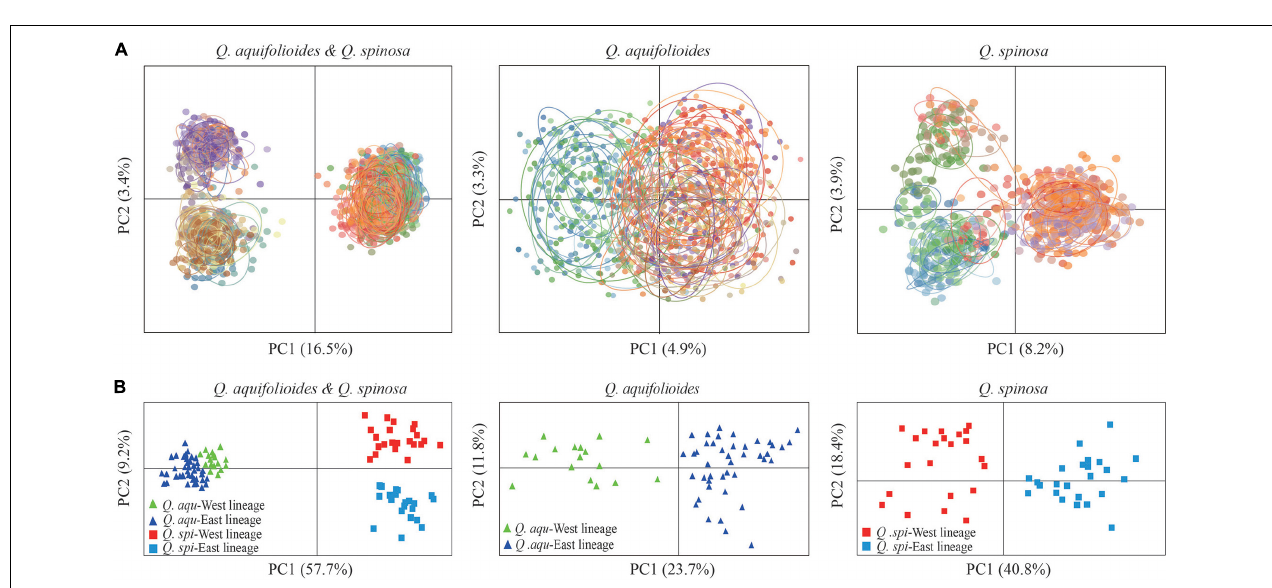
FIGURE 3 | Individual assignment to two (top) , three (middle) , and four (below) genetic clusters by S TRUCTURE of Q. aquifolioides and Q. spinosa . Each bar represents a single individual, with portions of the bar colored depending on the ancestry proportions estimated. The y -axis quantifies subgroup membership, and the x -axis shows the sample ID for each individual.